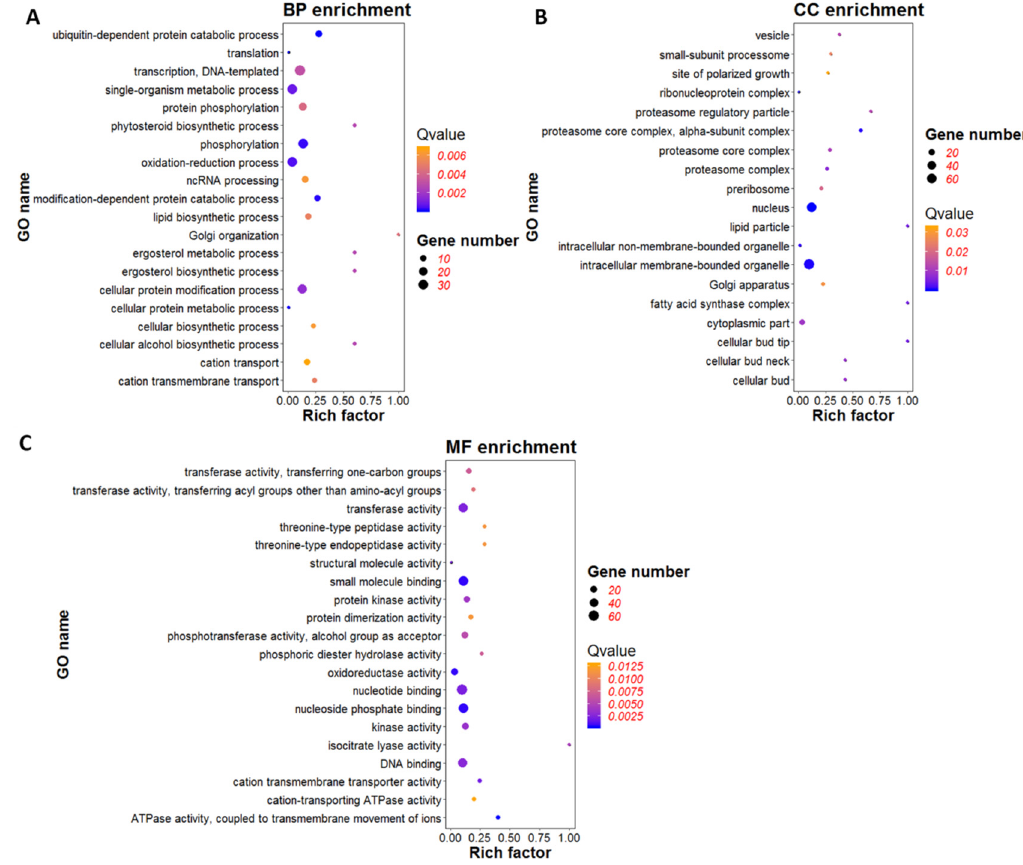
Figure 6. Gene ontology (GO) enrichment analysis of differentially expressed genes (DGEs). ( A ) GO enrichment analysis of DEGs in biological process (BP). ( B ) GO enrichment analysis of DEGs in cellular component (CC). ( C ) GO enrichment analysis of DEGs in molecular function (MF). The bubble graph displays GO items on the Y-axis and rich factor on the X-axis. The color of bubbles represents Q value. The size of bubbles represents the number of genes.